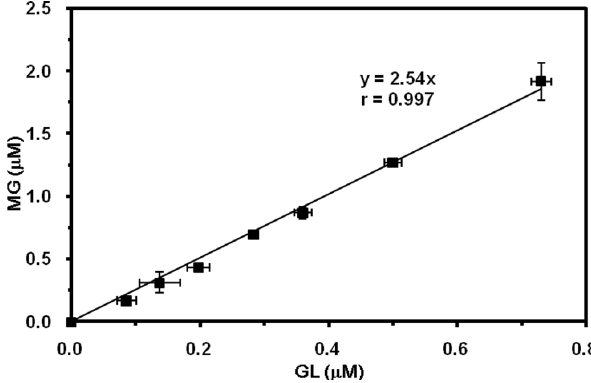
Fig. 3. The relationship between methyl glyoxal (MG) and glyoxal (GL) produced in the aqueous oxidation of isoprene. Samples were measured every 10min in the first 80min of the reaction.